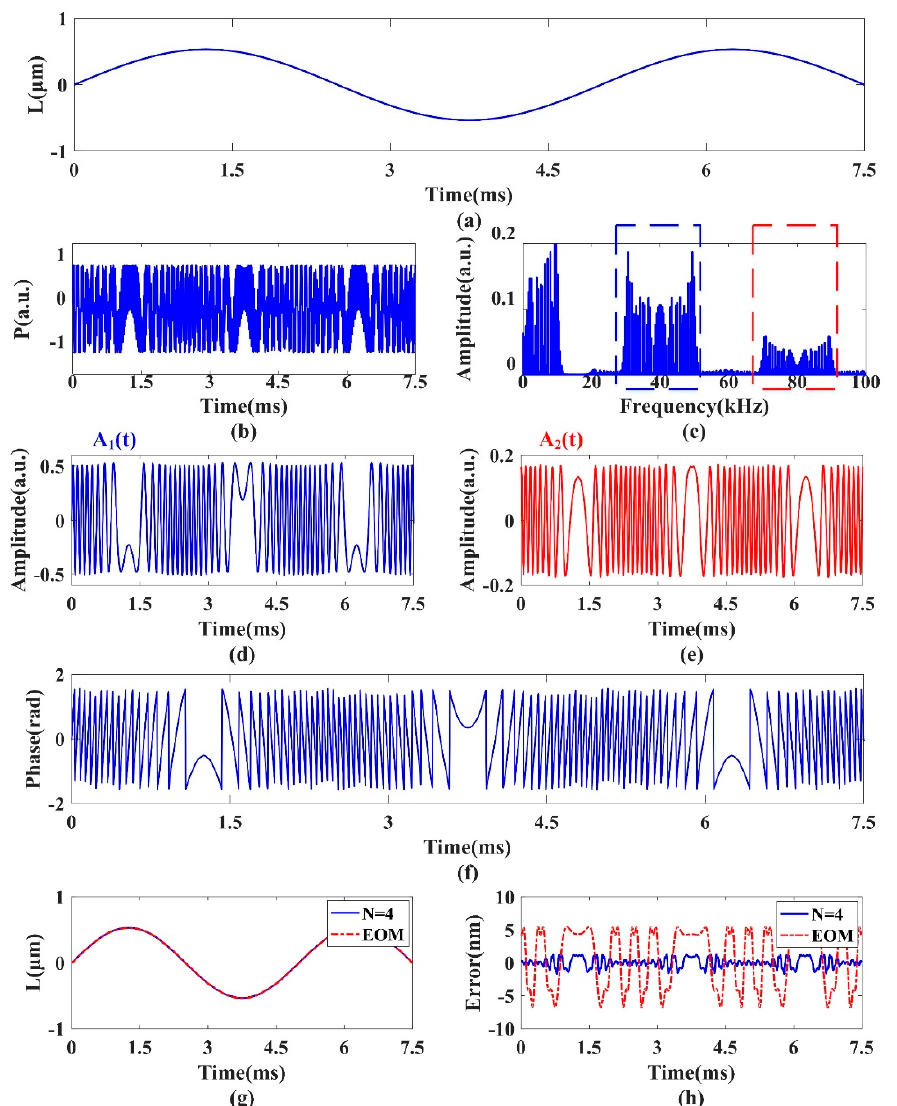
Figure 2. Realization of interference signal processing with A = λ . ( a ) Simulated displacement of the outer objective. ( b ) SMI signal with phase modulation. ( c ) Frequency spectrum of SMI signal. ( d ) Amplitude of the first harmonic. ( e ) Amplitude of the second harmonic. ( f ) Wrapped phase. ( g ) Reconstructed displacement of EOM-PM and MR-PM. ( h ) Displacement reconstruction error of EOM-PM and